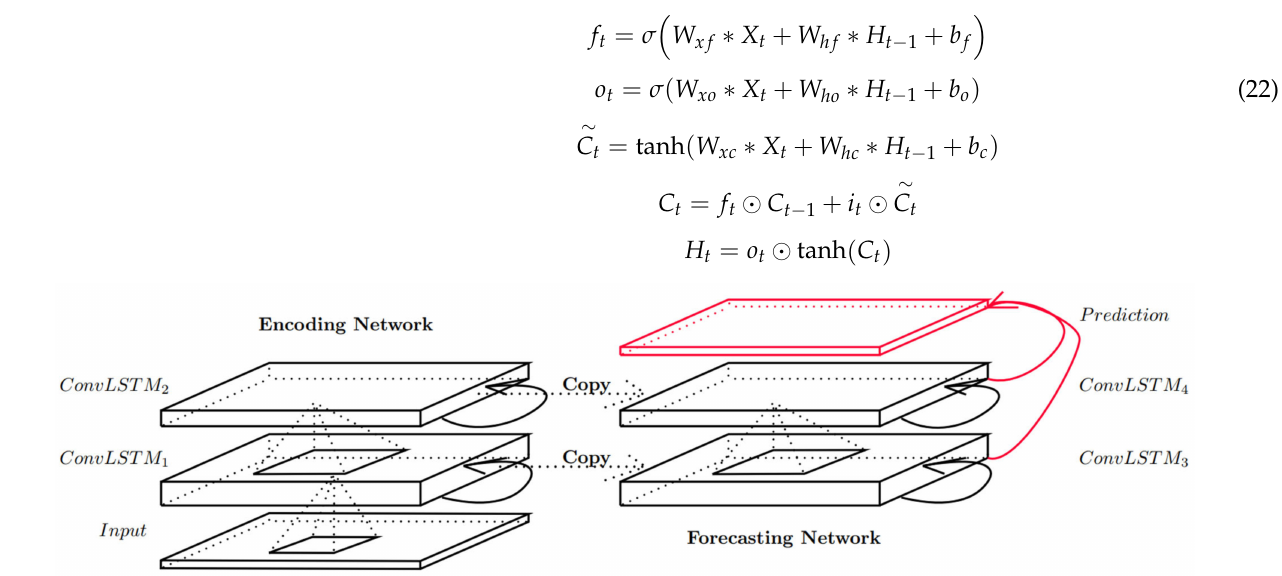
Figure 7. Encoding-forecasting ConvLSTM network